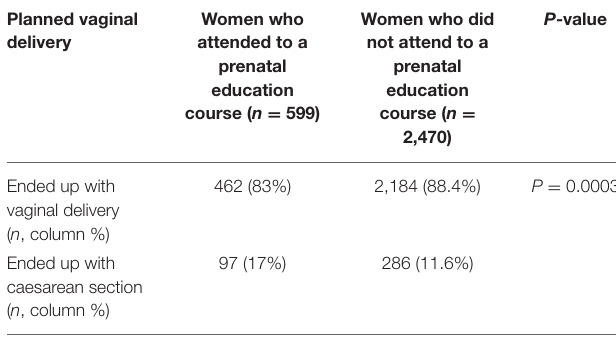
TABLE 4 | The comparison of emergency caesarean section in planned vaginal delivery between women who attended to a prenatal education course and who did not.